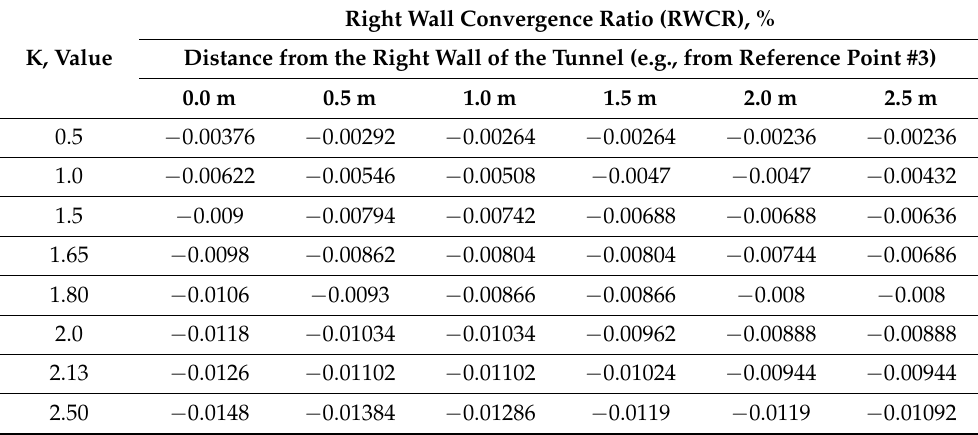
Table 3. Ratio of right wall convergence (RWCR) at various in situ stresses and different distances from the right wall of the tunnel (e.g., from reference point #3).